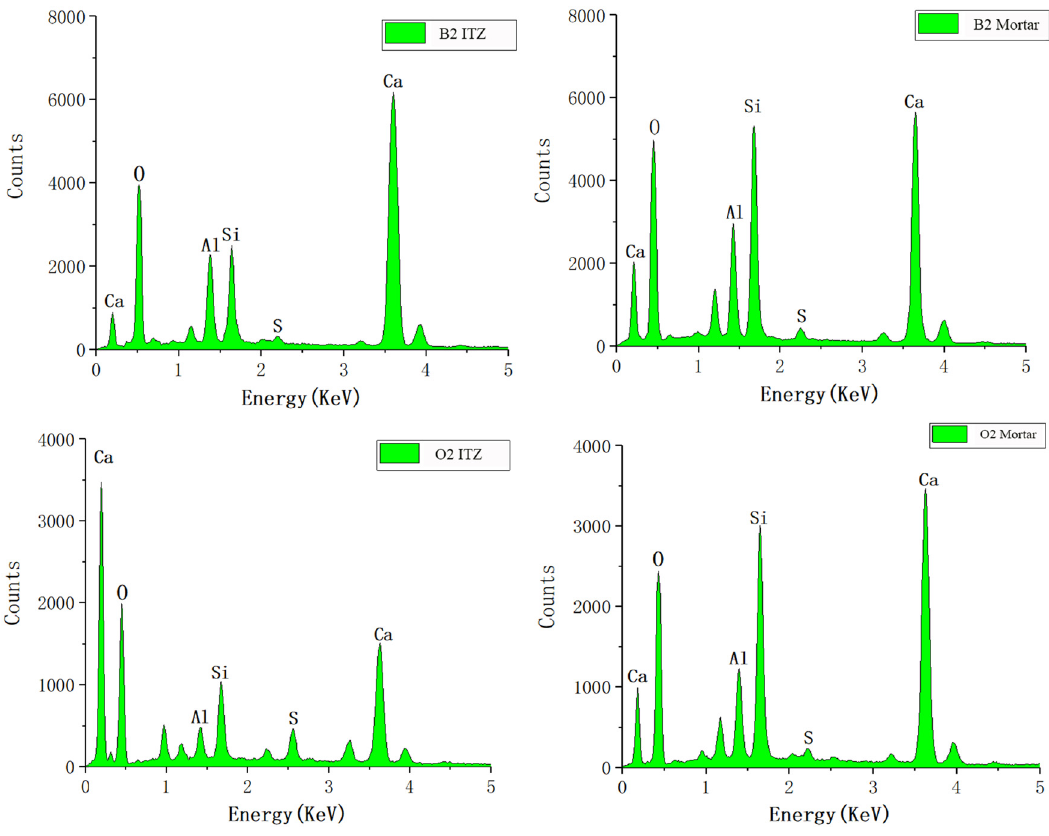
Figure 12: Energy spectra from element analysis.